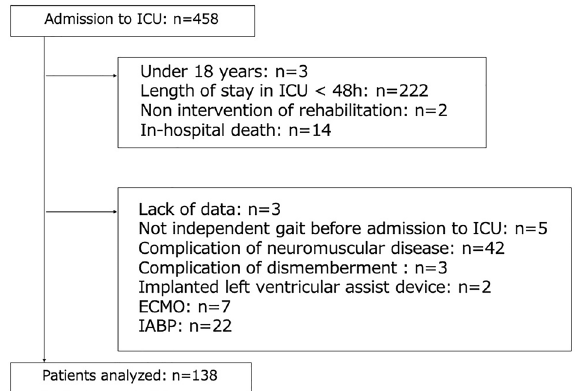
Figure 1. Flow diagram. ICU intensive care unit, ECMO extracorporeal membrane oxygenation, IABP intra- aortic balloon